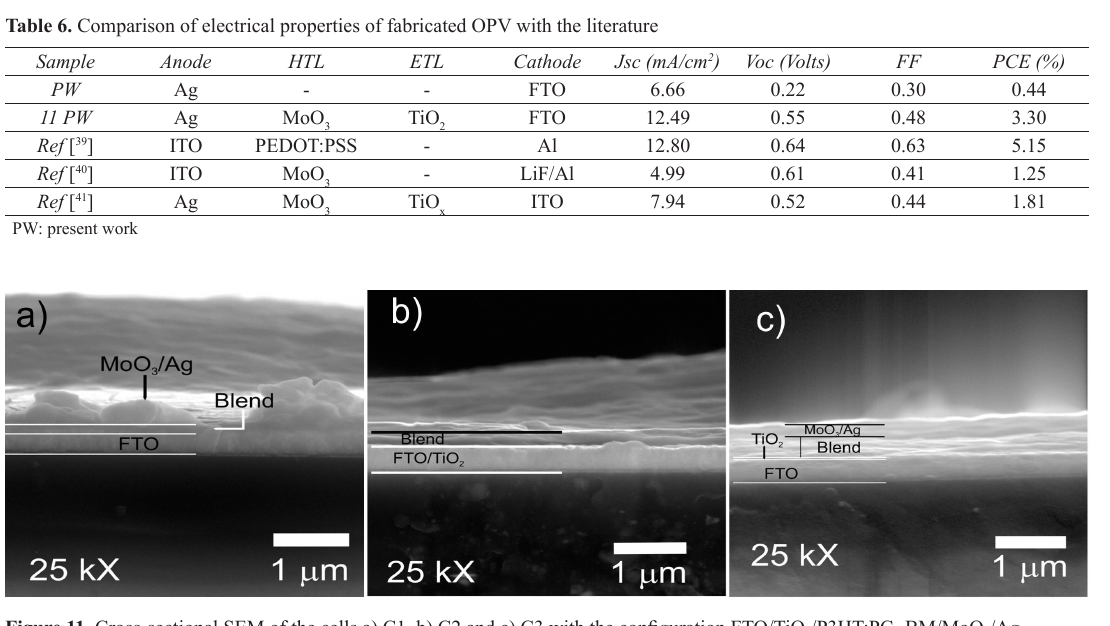
/P3HT:PC BM/MoO 2 61 3